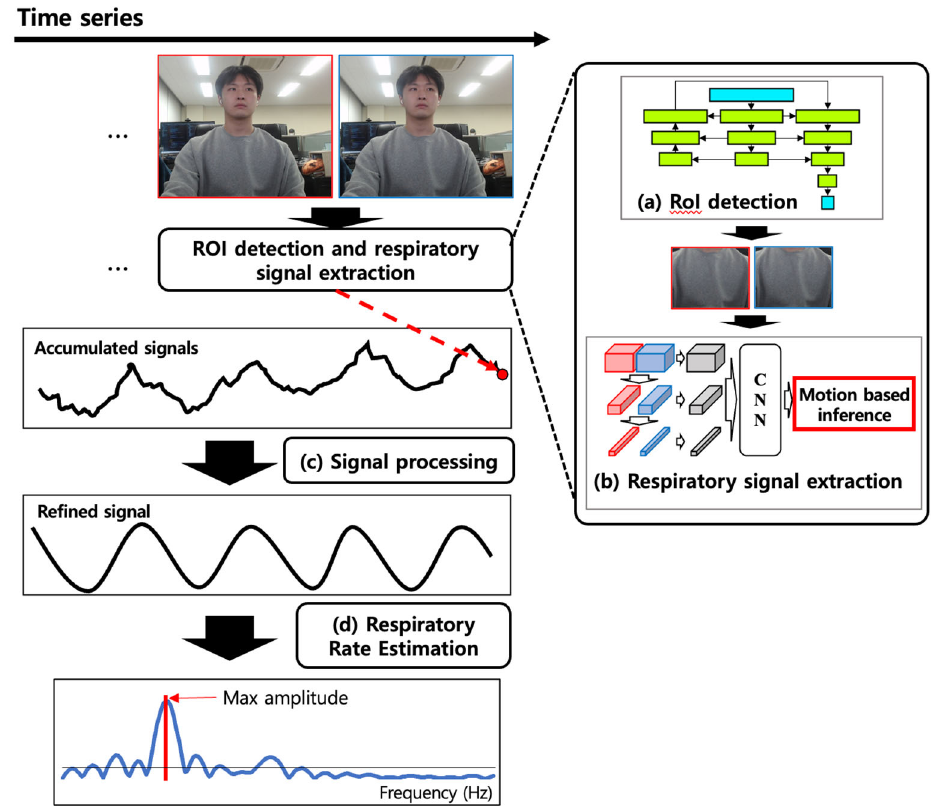
Figure 3. Overall process of the proposed method.